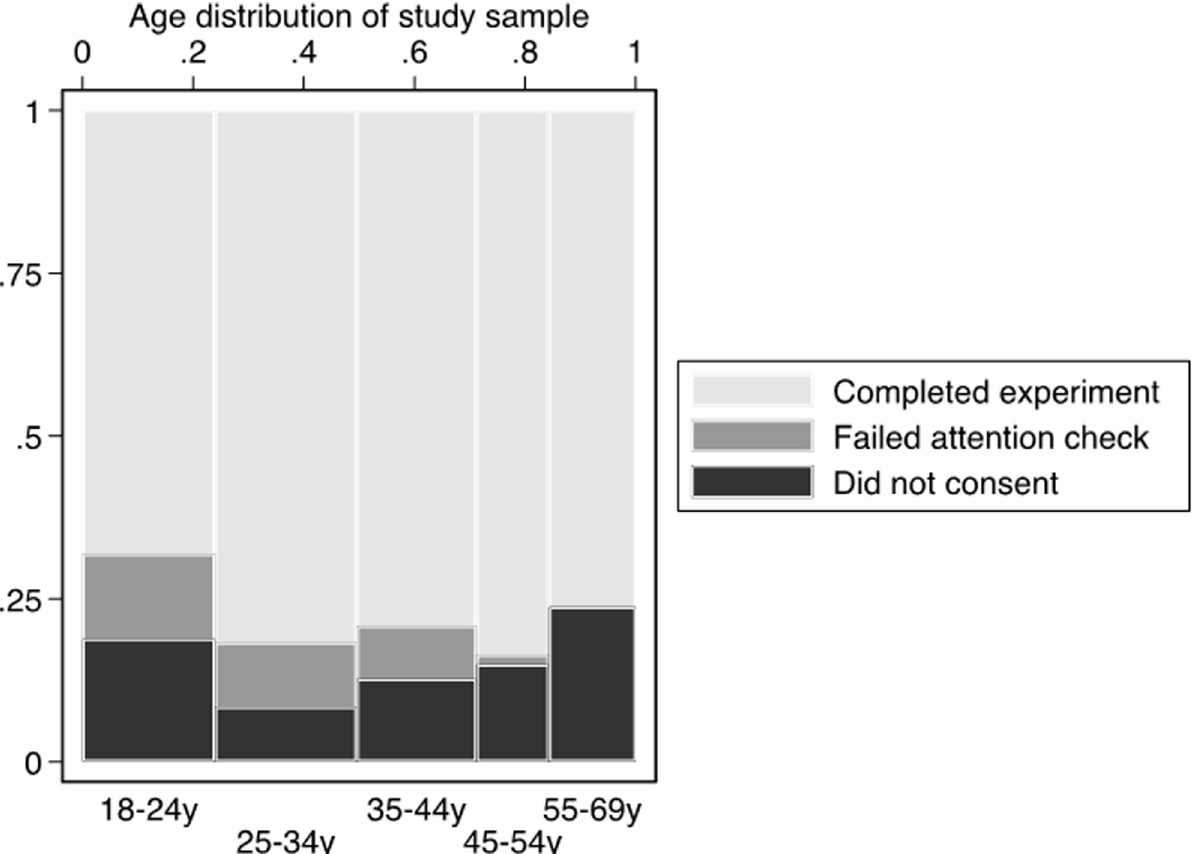
Fig 2. Age-related selectivity of study sample (n = 510). Notes: The width of each bar represents the proportion of the study sample included in each age group.